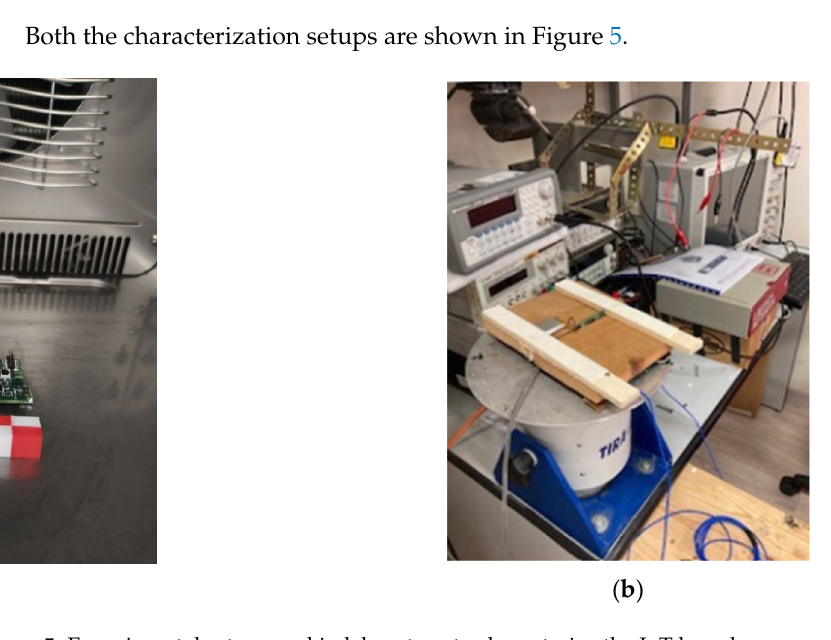
Figure 6. Characterization in terms of temperature at 50% of relative humidity.